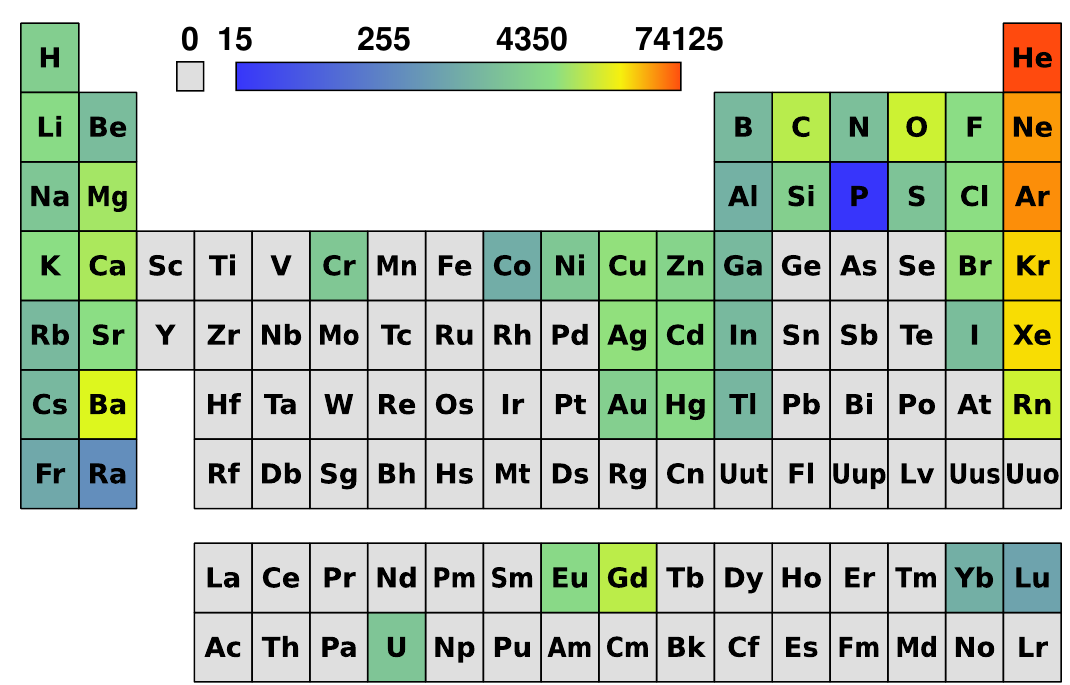
Figure 6. Heatmap of the number of records on the LXCat website listed by atomic